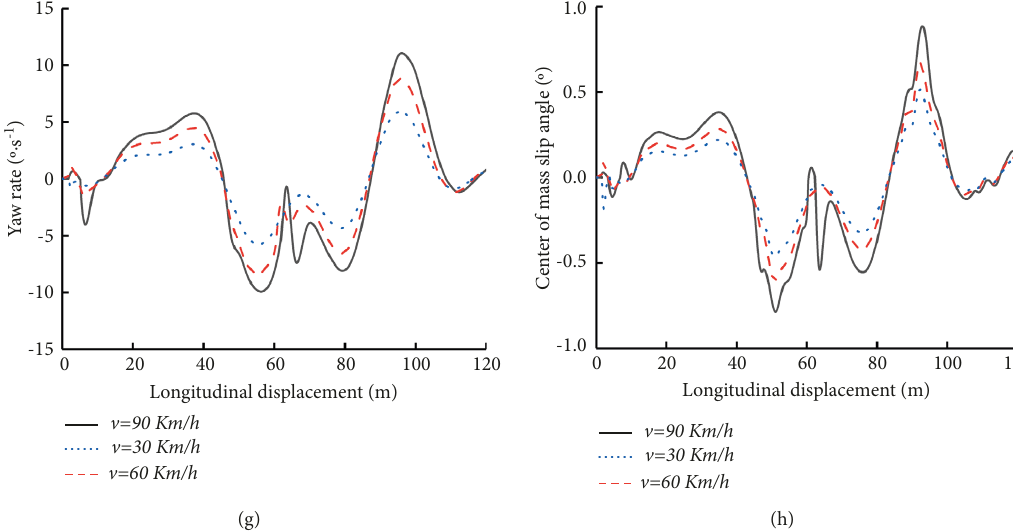
Figure 16: Tracking control renderings. (a) Lateral position tracking comparison. (b) Lateral position tracking error. (c) Yaw angle tracking comparison. (d) Yaw angle tracking error. (e) Front-wheel angle diagram. (f) Lateral acceleration diagram. (g) Yaw rate diagram. (h) Center of mass slip angle